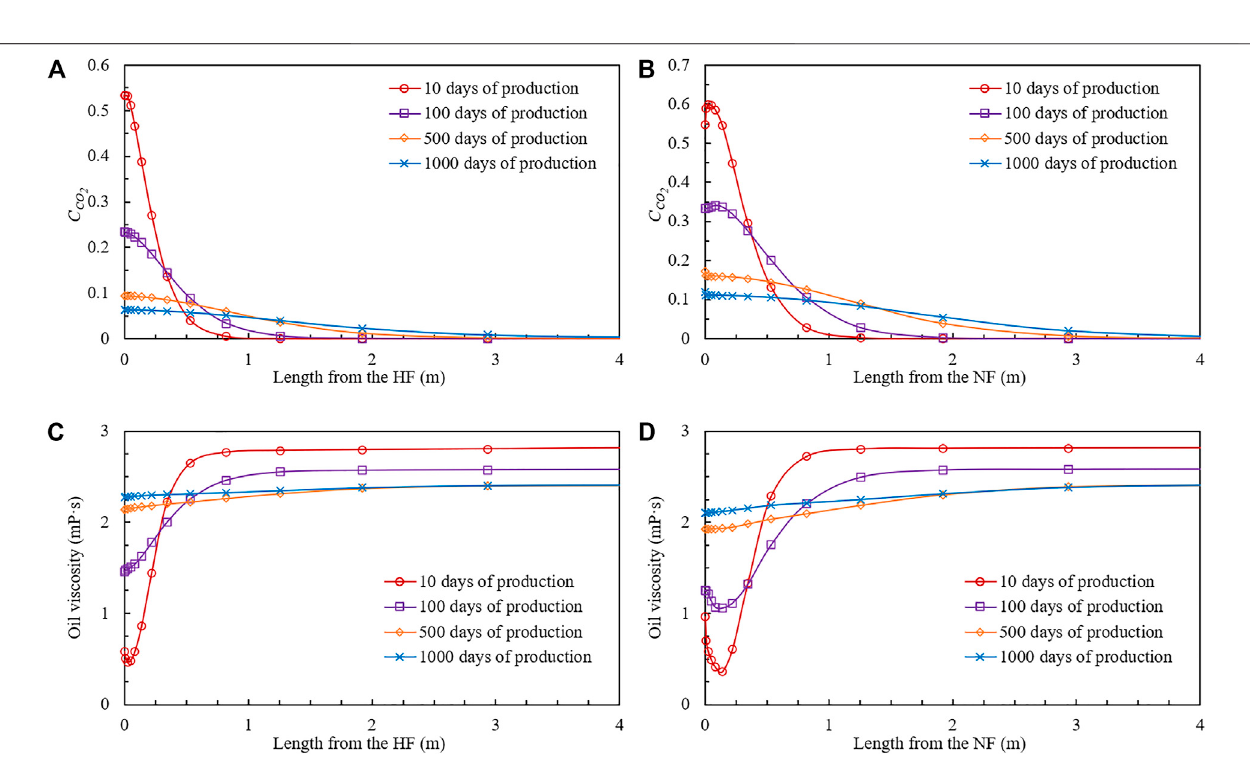
Frontiers in Earth Science |